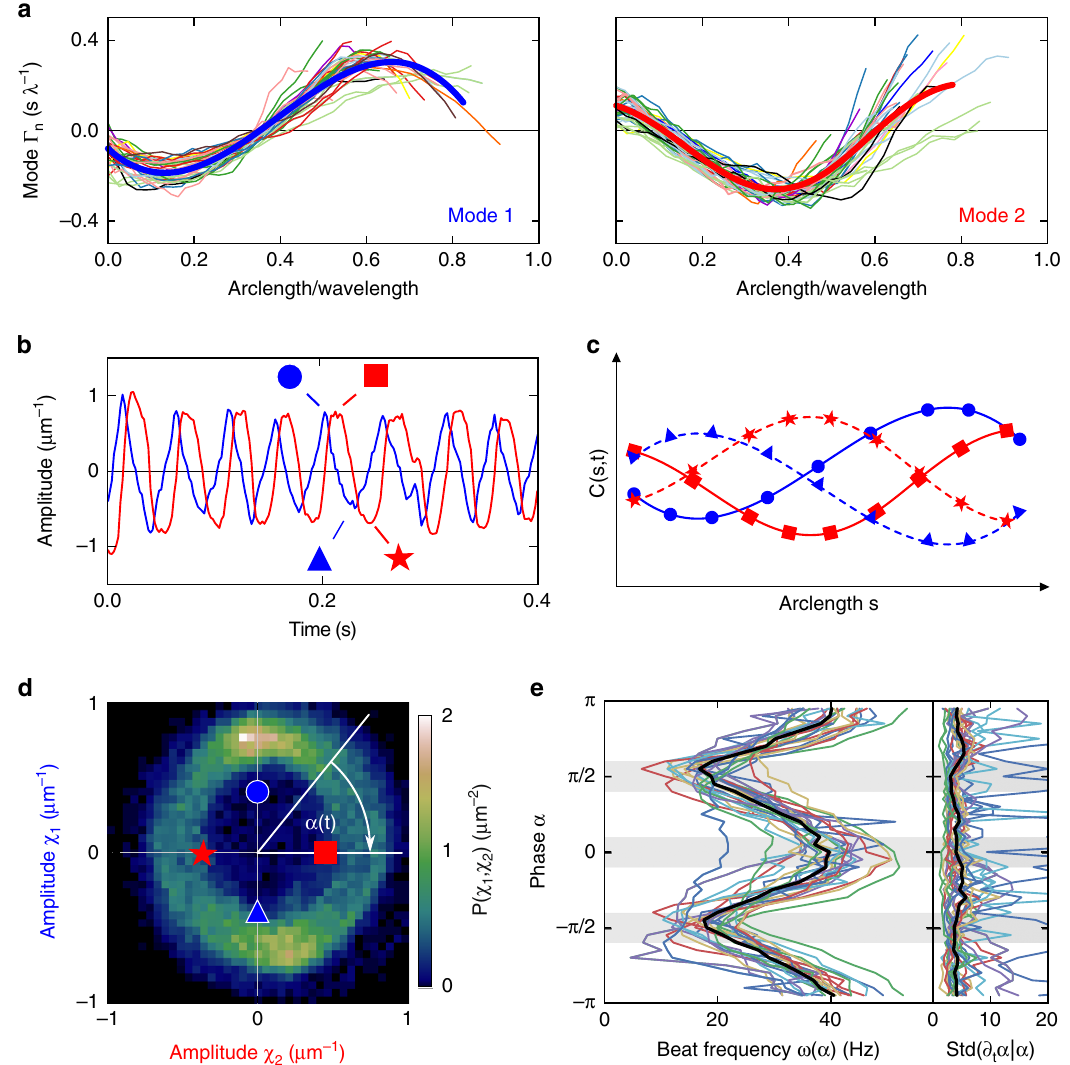
Fig. 2 Principal-component analysis of the fl agellar beat. a Superposition of the two main normal modes of the fl agellar beat for n = 35 human sperm cells. Each trace corresponds to a different cell. Although each cell has a different set of eigenmodes, when rescaled by the wavelength λ , the individual modes collapse onto a common curve (solid blue and red lines; see Methods). The wavelength appears longer than the fl agellum, because it is traced only partially. b Time evolution of the mode amplitudes χ 1 and χ 2 for a representative recording. Of note, χ 2 lags behind χ 1 by a phase of π /2. The symbols (blue circles, red squares, blue triangles, red stars) indicate the modes shown in panel c , and correspond to the beat phase depicted in d . c Illustration of the composition of the beat by principal modes. The peak of the wave travels from left to right. d Histogram of the joint probability P ( χ 1 , χ 2 ), averaged for 1.5 s from 26 different cells. During a full beat cycle, the phase α = arctan( χ 2 / χ 1 ) varies between 0 and 2 π . The symbols indicate the phase of the amplitudes in b . e Beat frequency at a fi xed phase for each cell as ω ( α ) = ⟨ ∂ t α | α ⟩ . The gray stripes highlight the phases of minimal and maximal frequency (20 Hz and 40 Hz, respectively). The black line indicates the median. The standard deviation of ω ( α ) is nearly constant (right